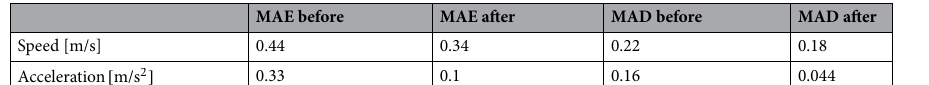
MAE before MAE after MAD before MAD after Speed [m/s] 0.44 0.34 0.22 0.18 Acceleration [ m/s 2 ] 0.33 0.1 0.16 Table 2. Mean absolute error and median absolute deviation on speed and acceleration between the two observed signals before and after the application of pLO method.